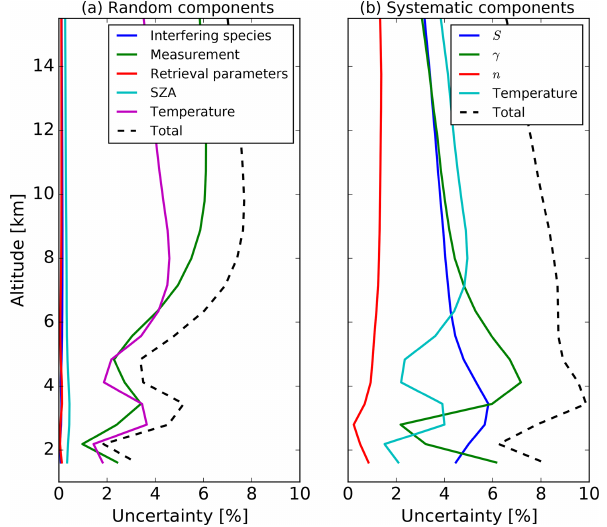
Figure 3. Mean vertical profiles of the most important random (a) and systematic (b) uncertainty components for the retrieval of WV in BLD from 2010 to